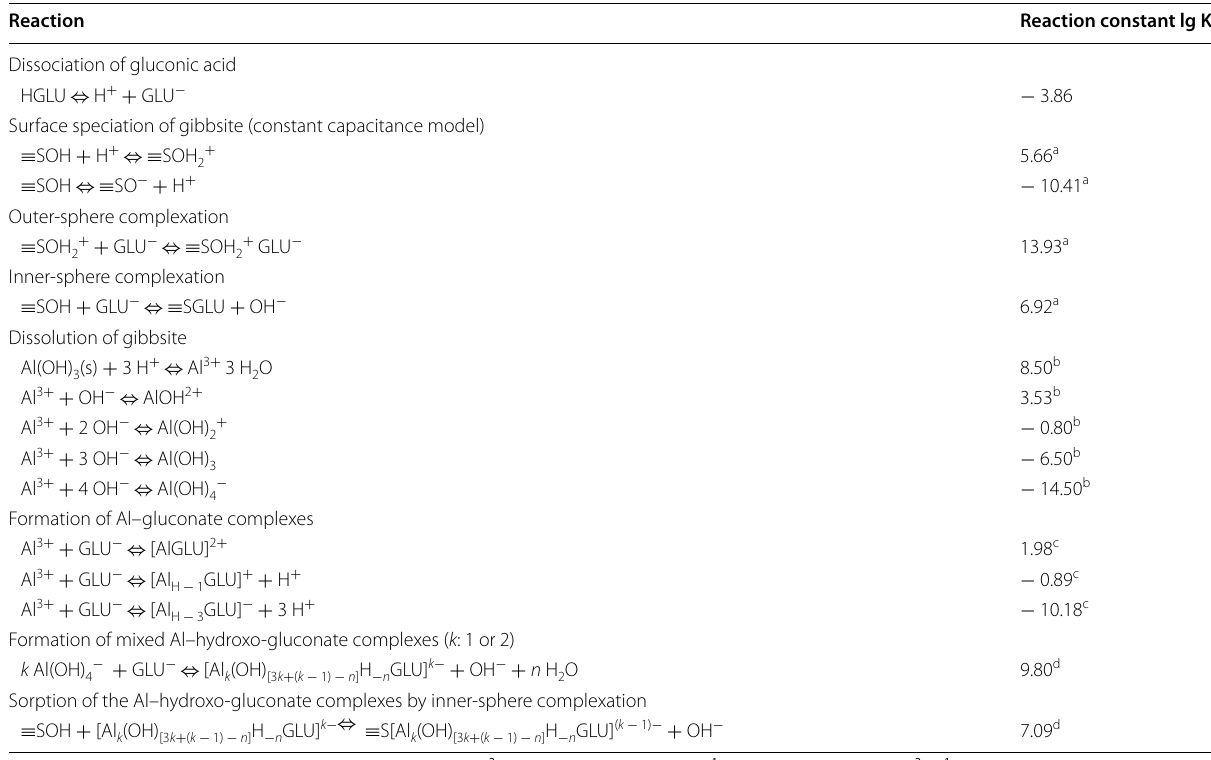
Table 5 Speciation, dissolution, and complexation reactions and reaction constants involved in the sorption of gluconic acid to gibbsite within the pH range of 3.4–12.2